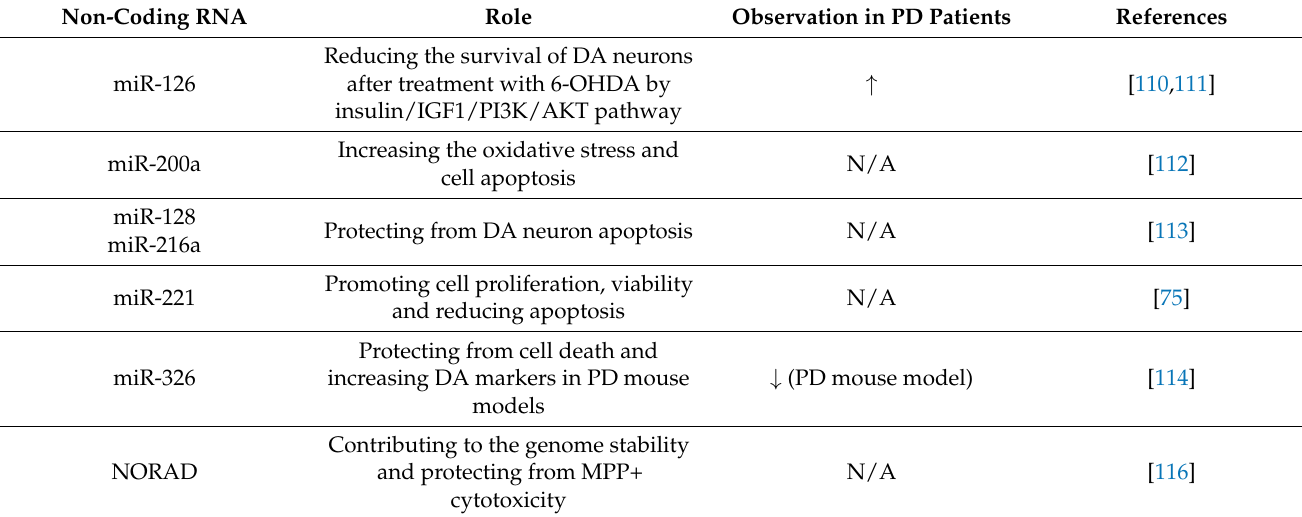
Table 5. Schematic overview of miRNAs and lncRNAs involved in the survival of DA neurons and DA cell lines. Non-Coding RNA Role Observation in PD